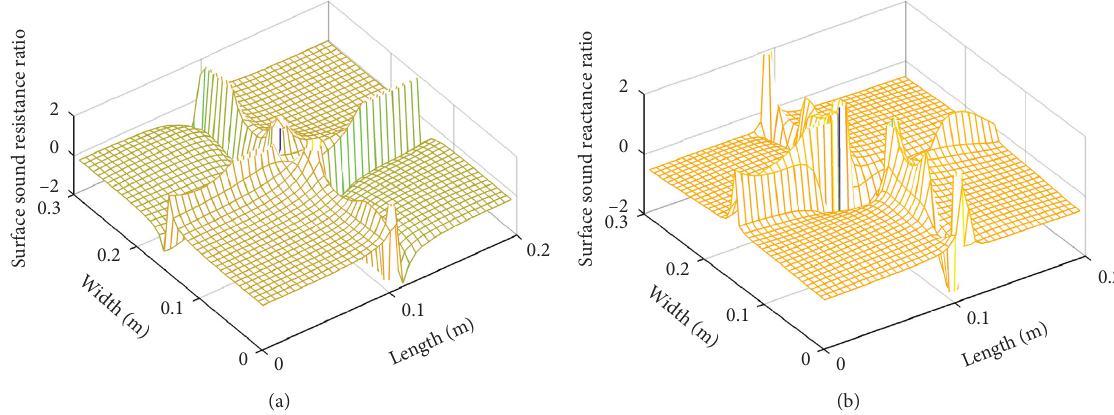
Figure 7: Surface sound impedance ratio of the active MPPA on the resonant frequency of the (2, 2) mode after control: (a) sound resistance ratio and (b) sound reactance ratio.